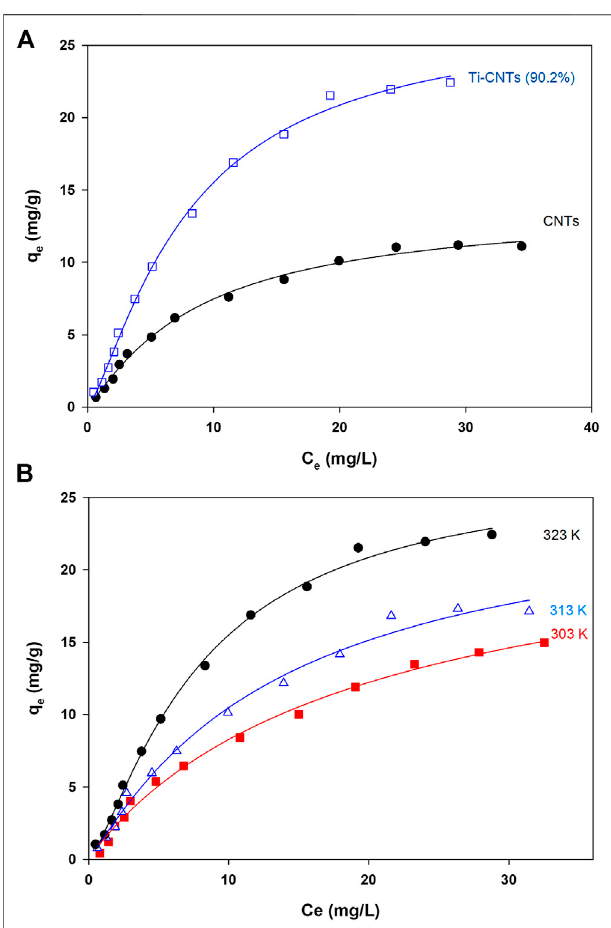
FIGURE 5 | Adsorption isotherms A: Co ions adsorption by CNTs and Ti-CNTs (90.2%) B: Adsorption isotherms of Co by Ti-CNTs (90.2%) at different temperatures (Lines passing through experimental points representing Langmuir-Freundlich